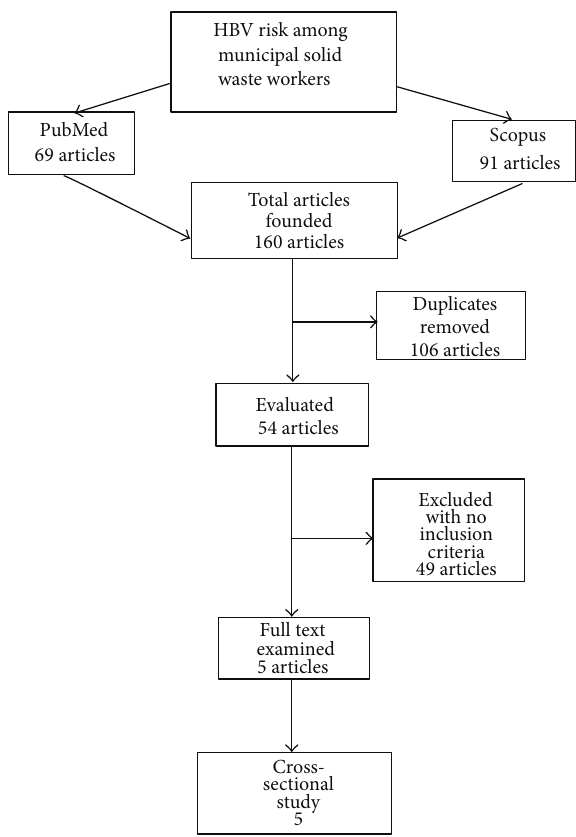
Figure 1: Flow chart of the selection of the